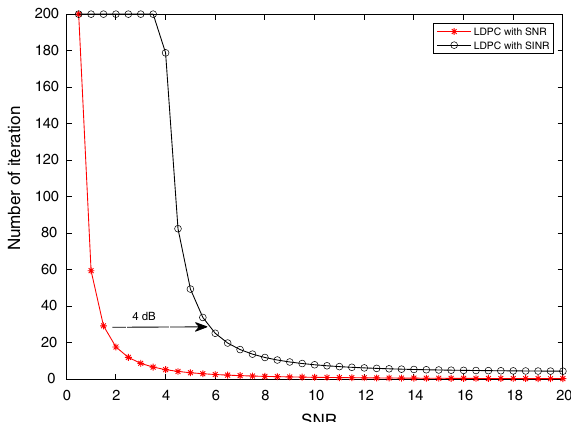
Fig. 13 Comparison of HIC-MPA and MUD in terms of complexity for Ŵ